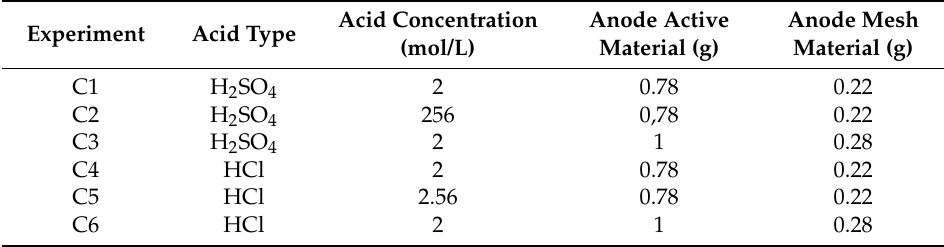
Table 2. Leaching of anode active material including the supporting mesh. The experiments were performed at 25 ◦ C under atmospheric pressure, s/L = 1/20 (g/mL), stirring rate = 500